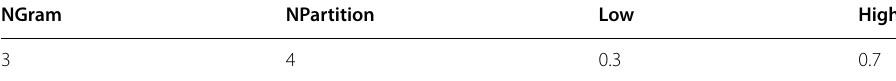
Table 7 The used parameters’ values of our feature extraction code NGram NPartition